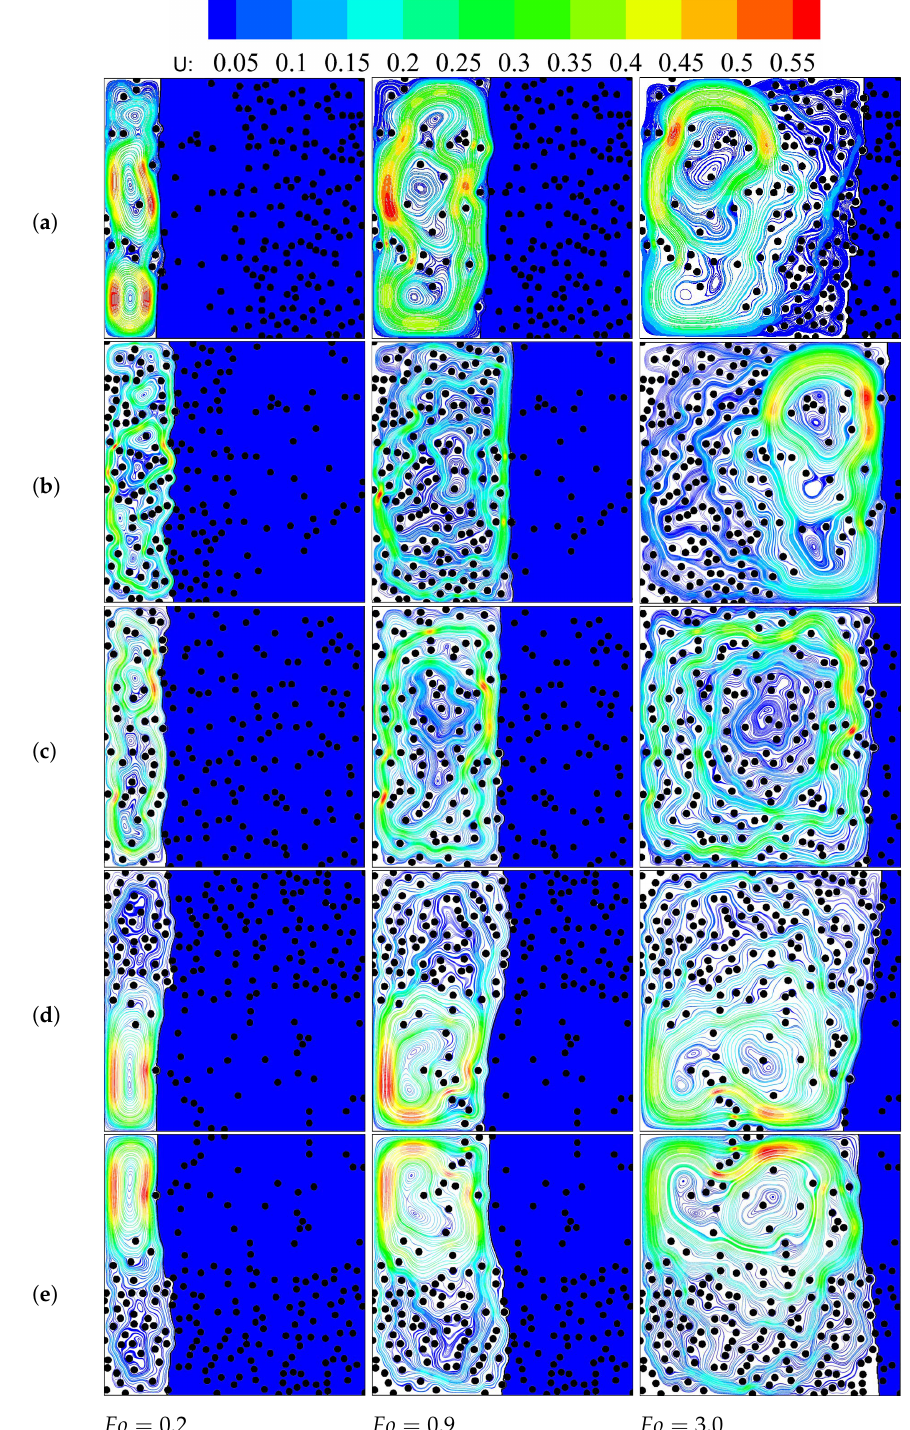
Figure 6. The distribution of the liquid fraction for different gradient structures at Ra = 10 4 , in which Ste = 0.1, and Pr = 0.2: ( a ) Case A: negative gradient; ( b ) Case A: positive gradient; ( c ) Uniform gradient; ( d ) Case B: negative gradient; ( e ) Case B: positive